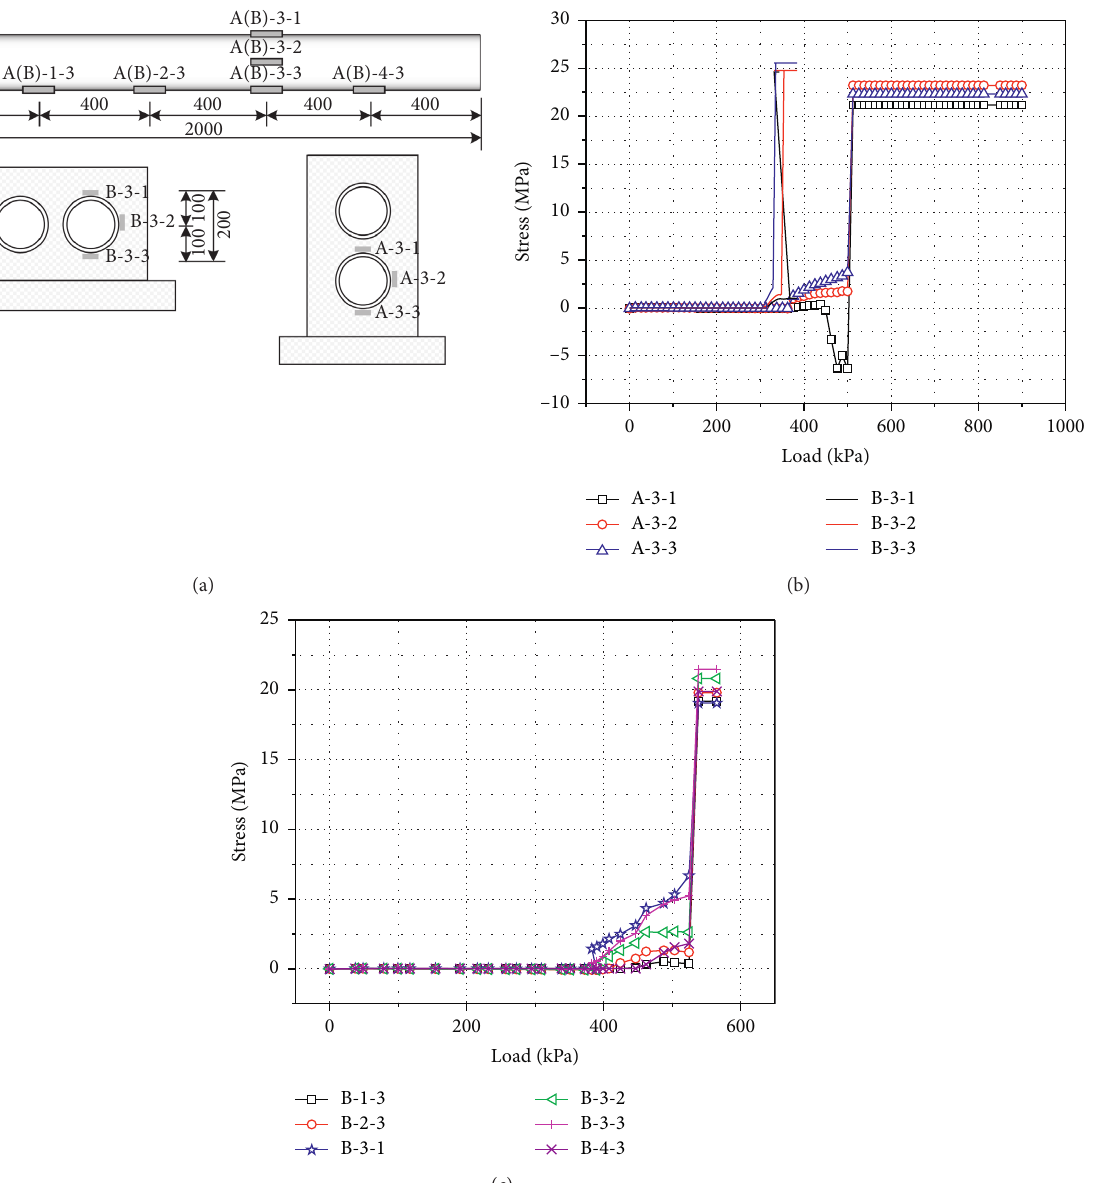
Figure 13: Stress evolution of HDPE conduits. (a) Measuring points of HDPE conduits. (b) Load-stress curve of A2 and B2. (c) Load-stress curve of